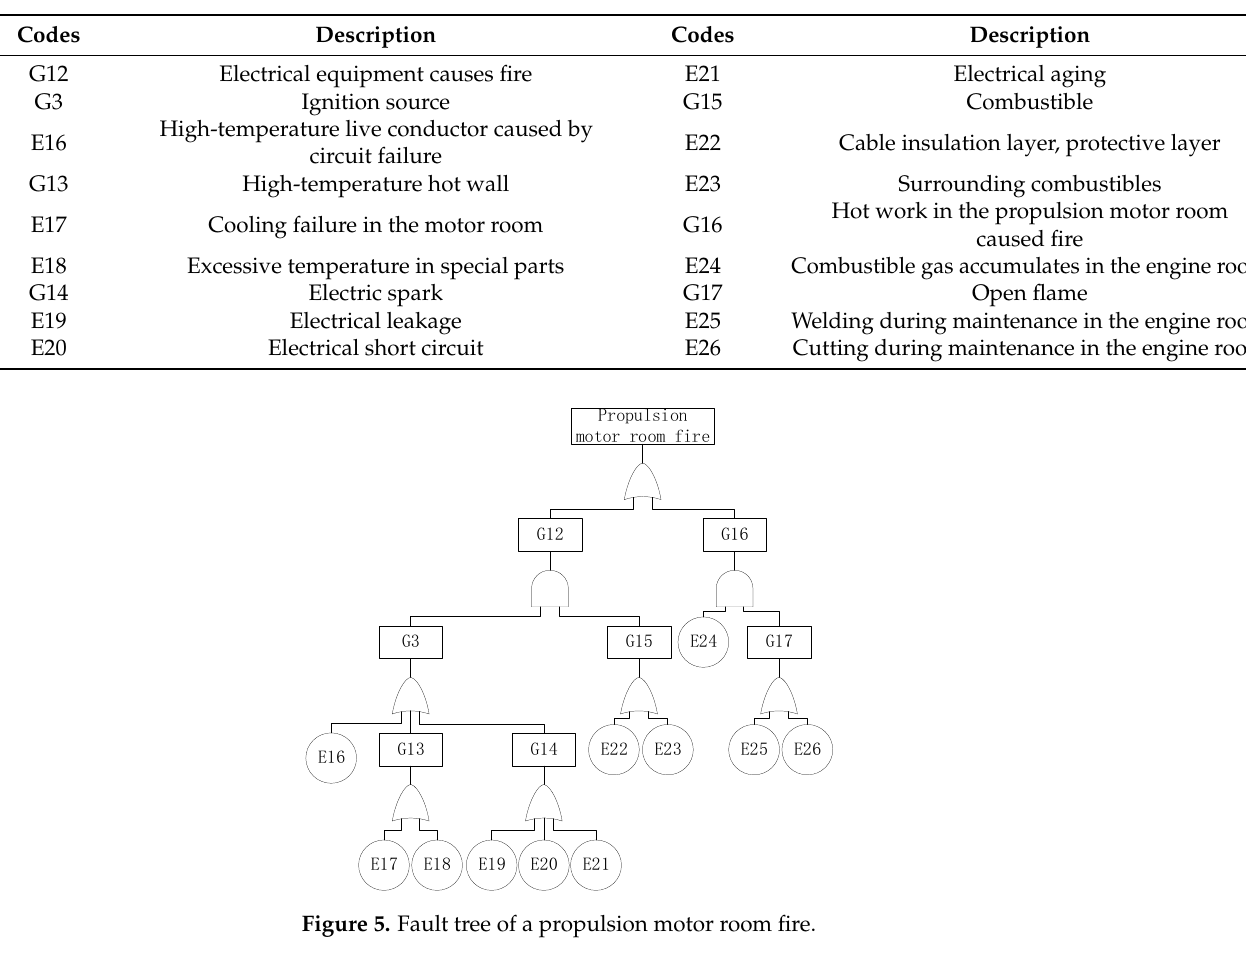
Table 8. Logic gates and principal events of a propulsion motor room fire.